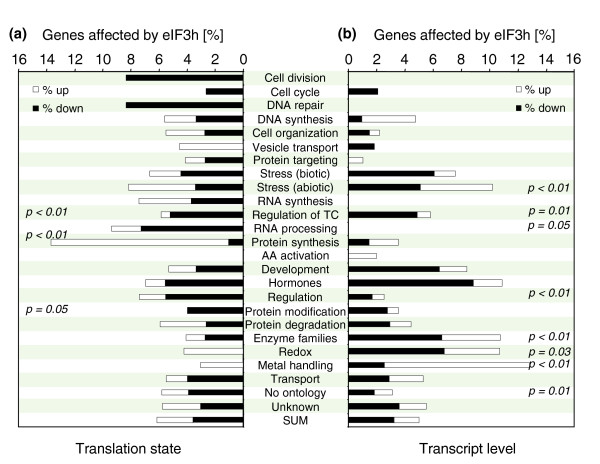
Survey of trends in translational stimulation and repression among functional classes of genes. The changes in (a) translation states or (b) transcript level observed between wild type and eif3h are shown after gene ontology analysis using MapMan v1.8.0 [33]. Bars represent the percentage of responsive genes in a particular class when a two-fold cut-off was applied. X2 tests were carried out to evaluate the extent of deviation from the average pattern and p values are given.